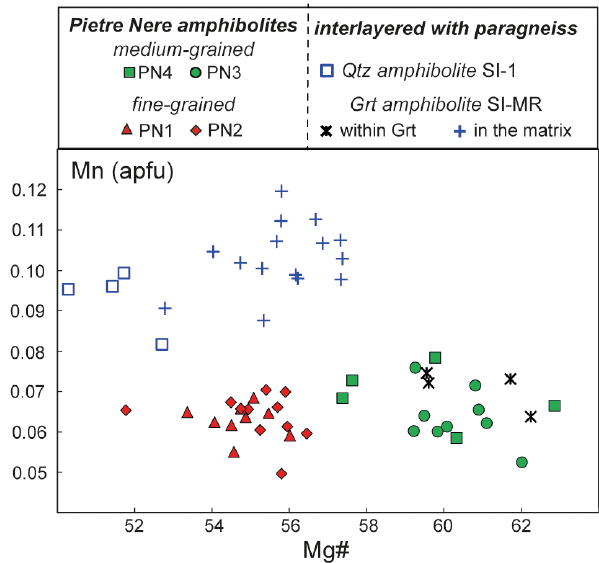
Figure 6. Variation of Mn (apfu, atoms per formula unit) vs. Mg# in